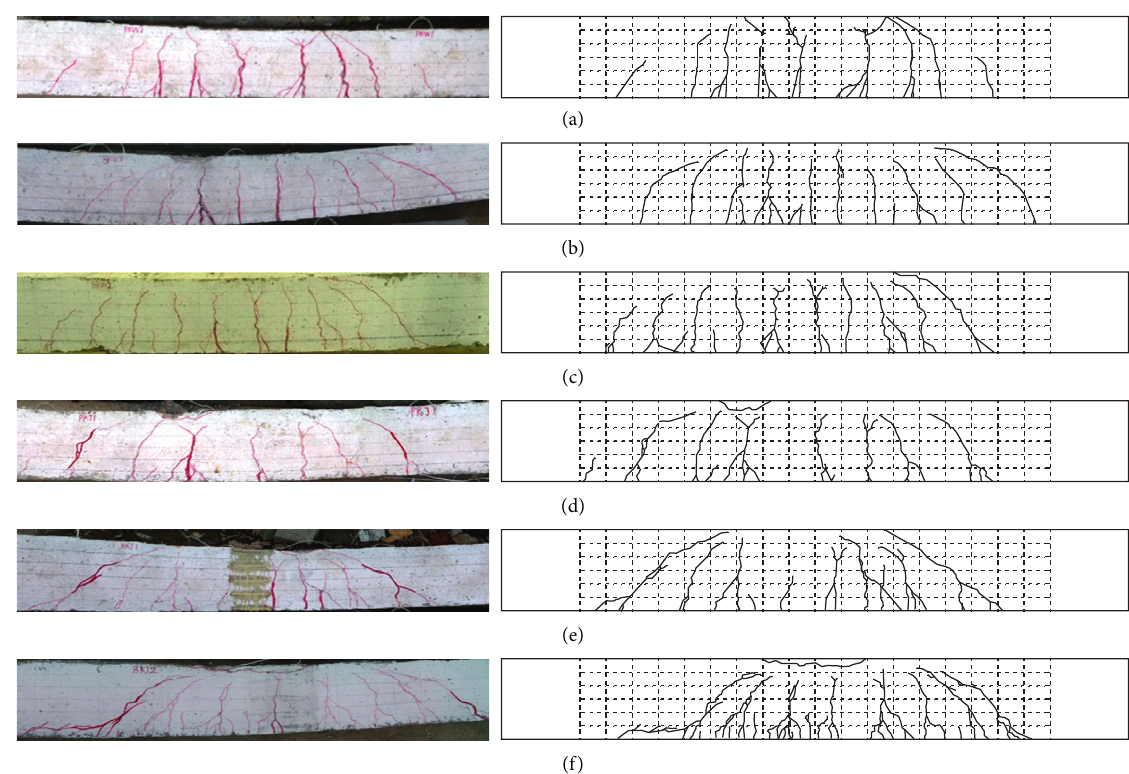
Figure 7: Photographs and crack patterns of all beams. (a) PKW1. (b) BKW1. (c) BKW2. (d) PKJ1. (e) BKJ1. (f)